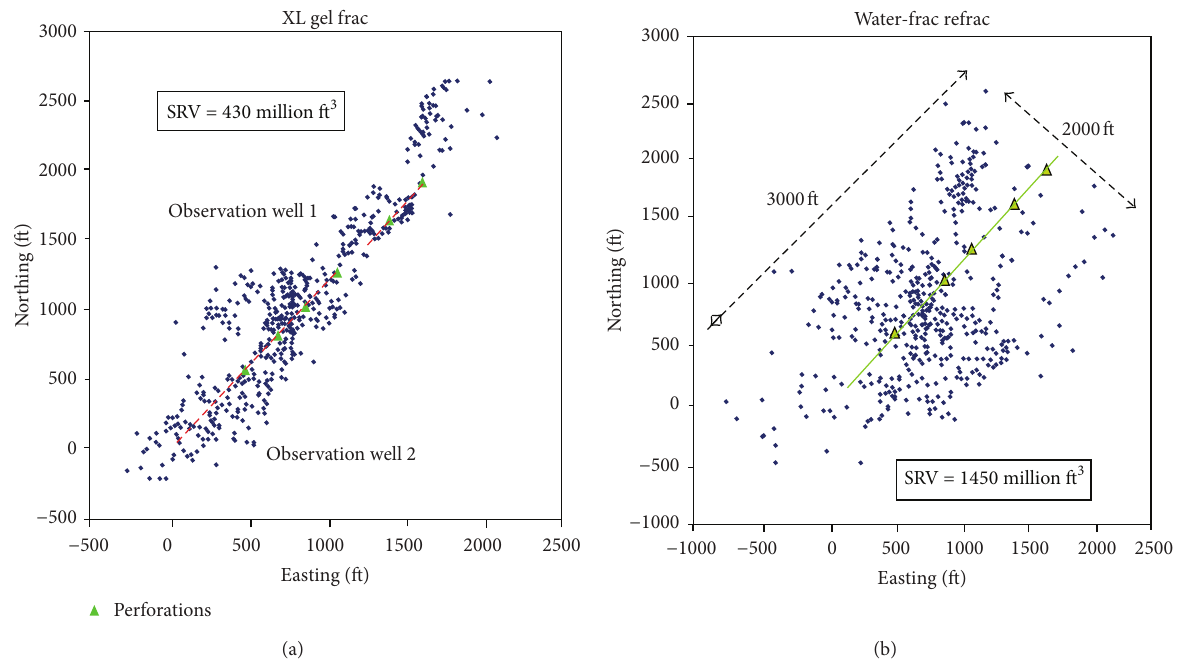
Figure 13: SRV comparison of using gel fracturing fluid and slickwater fracturing fluid